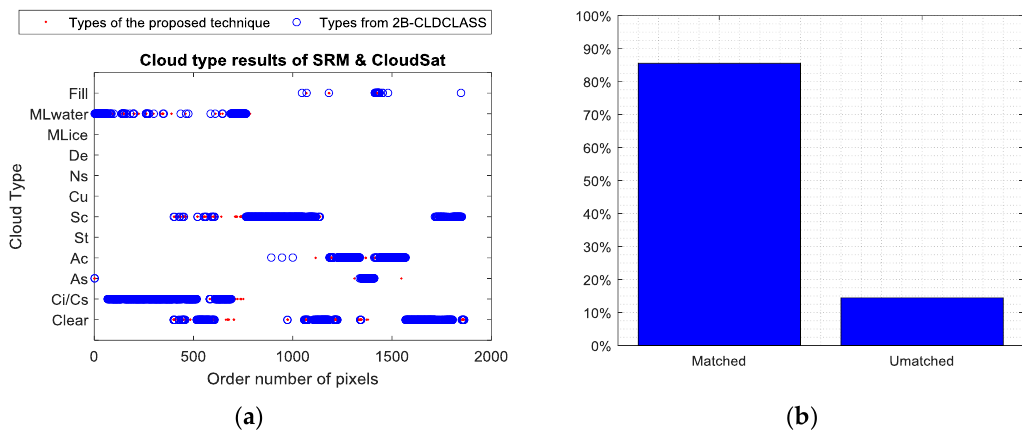
Figure 15. Results of the proposed technique and cloud types from 2B-CLDCLASS [7,40] under the condition that cloud types of no potential CPR pixel with the same position information were used as those of recipient pixels, ( a ) is scattered distribution, where points are cloud types of the proposed technique while circles stand for types from 2B-CLDCLASS. ( b ) Is statistical distribution, ‘matched’ means that the same type is determined by both methods, whereas ‘unmatched’ means that different types are classified.